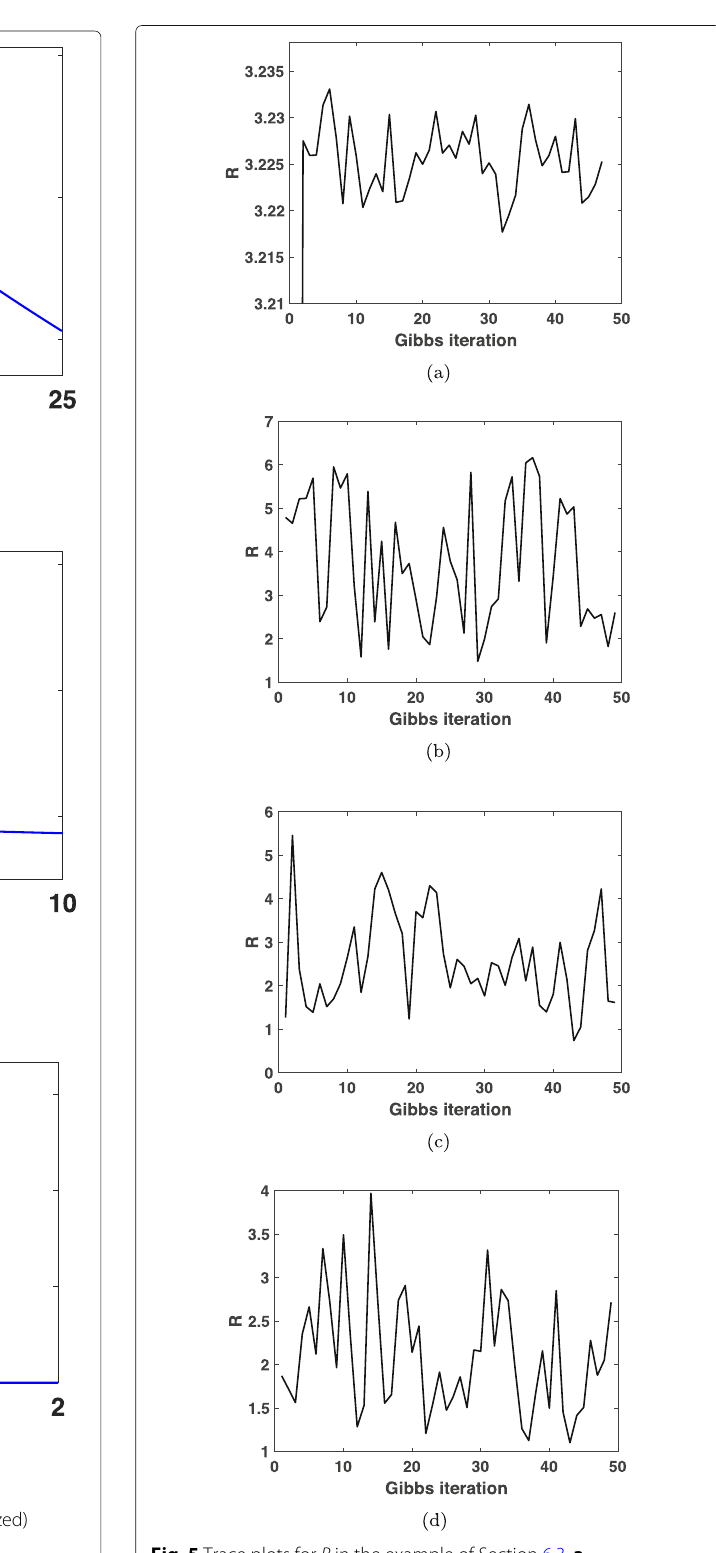
Fig. 4 Example of Section 6.3. a , b Examples of (unnormalized) conditional log-PDFs with λ = 0.1 and considering N = 20 observations. a Fixing (cid:22) = 4. b Fixing R = 0.7. c The (unormalized) conditional PDF corresponding to b